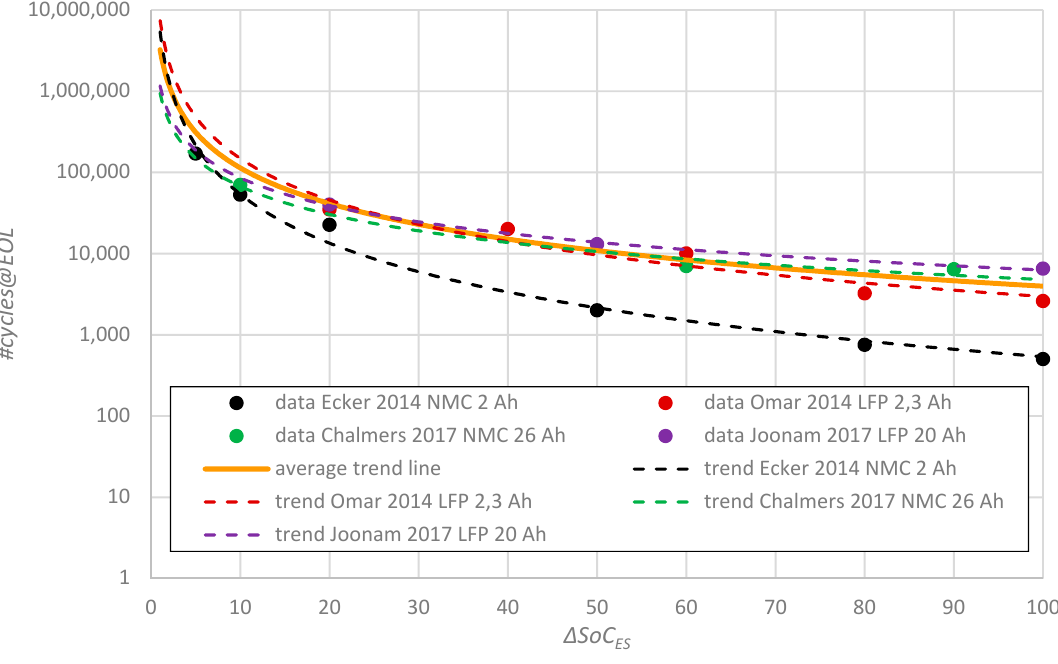
Figure 2. Number of allowed charging-discharging cycles vs. depth of discharge. Table 1. Maximum number of charging-discharging cycles, # cycle @ EOL l , depending on the depth of discharge level, ∆ SoC ES / E ES , nom . l- th 𝑺𝒐𝑪 𝑬𝑺 Bin